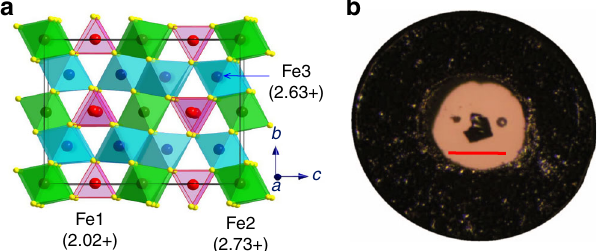
Fig. 1 Crystal structure and image of the Fe 4 O 5 crystal. a Orthorhombic crystal structure of Fe 4 O 5 at ambient conditions showing the different crystallographic positions for iron atoms (Fe1, Fe2, and Fe3) in different colors. The bond valence sum values are indicated near the cations. b Image of a single crystal of Fe 4 O 5 taken through one diamond window. A rhenium gasket of about 40 µ m thickness with a circular hole of